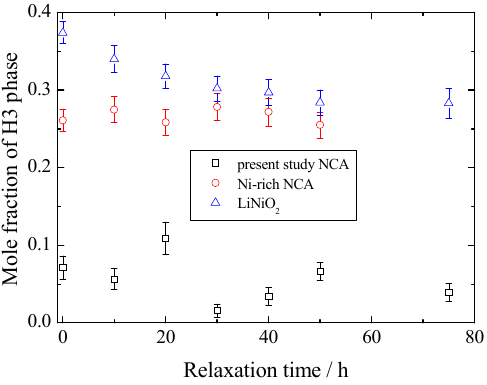
Figure 7. Calculated mole fraction change of H3 phase for LiNiO 2 , Ni-rich NCA and present study NCA. ∆ : LiNiO 2 , О : Ni-rich NCA, □ : present study NCA.